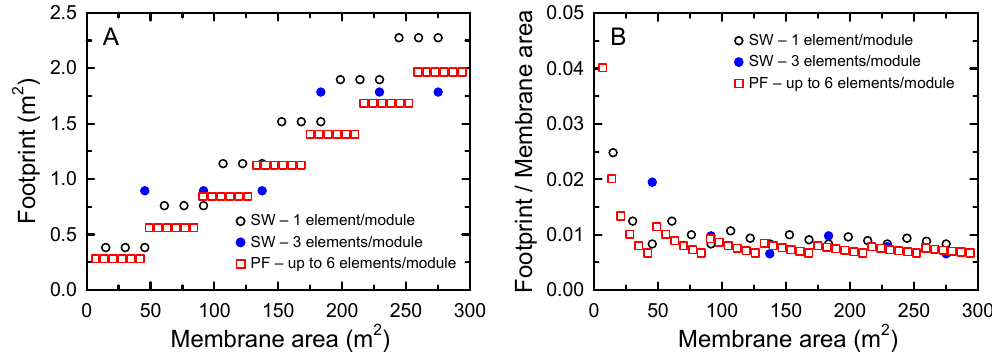
Figure 6. Estimation of the footprint ( A ) and footprint/membrane area ( B ) for SW FO and PF FO.